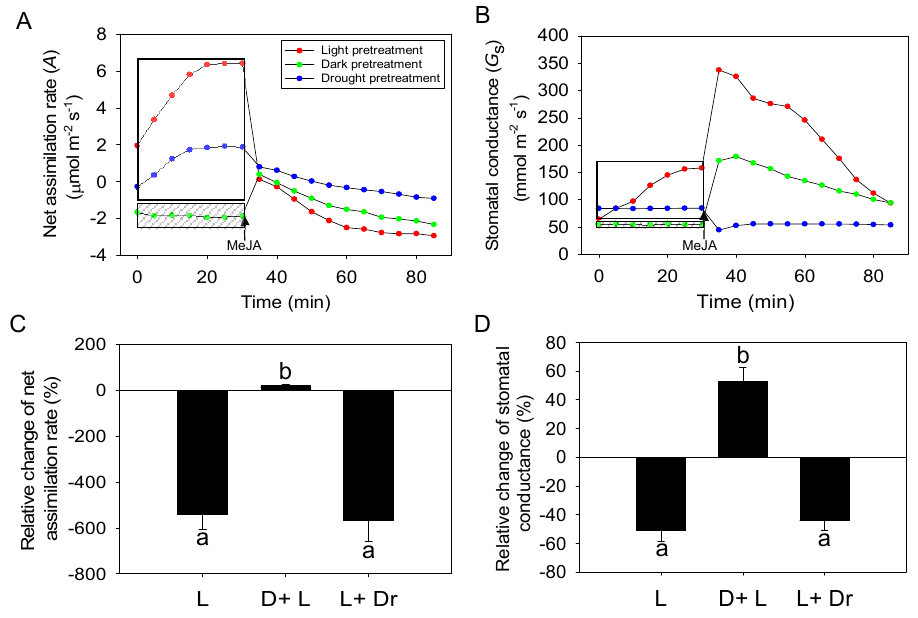
Figure 3. Modifications in net assimilation rate ( A ) and stomatal conductance ( B ) for representative leaves and average ± SE ( n = 3) relative changes of net assimilation rate ( C ) and stomatal conductance (Equations (7) and (8)); ( D ) upon application of 20 mM MeJA in Cucumis sativus subjected to three di ff erent pretreatments. All the data are presented on average ( n = 3). In the light pretreatment (standard treatment applied in all other experiments, the leaf was illuminated 30 min before the treatment. In the dark pretreatment, the leaf was maintained in the darkness for 30 min prior to treatment. In the drought treatment, the plant was non-irrigated for 3 days prior to treatment until leaf water potential decreased to − 1.2 MPa. The MeJA application was always conducted in the light and the leaf was illuminated through the rest of the experiment (between 30–90 min). The shaded frame in the figure denotes the dark pretreatment, and the non-shaded frame the pretreatment under light condition. The moment of MeJA spraying (30 min) is denoted. Di ff erent letters (a, b) in ( C ) and ( D ) denote statistically significant di ff erences among the means according to ANOVA followed by Turkey test ( p < 0.05). L: light; D + L: Dark + Light; L + Dr: Light +